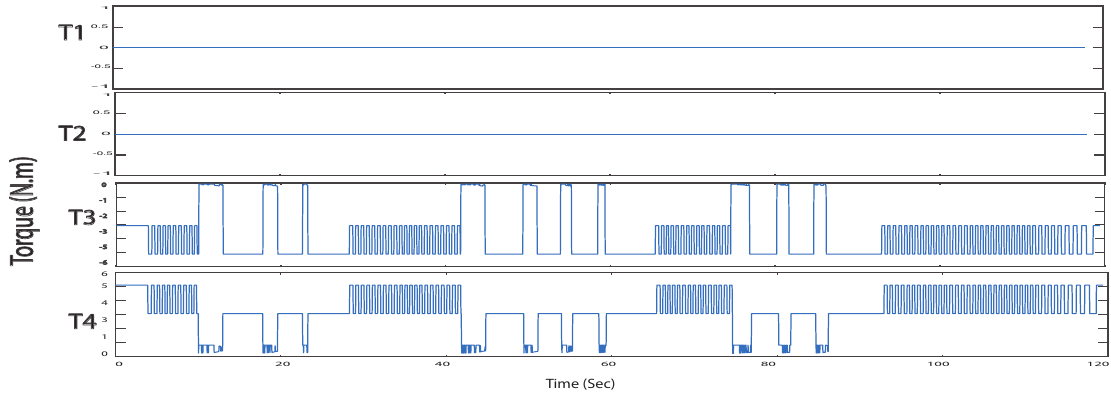
Figure 16. Path of the robot for state 5: Front wheels are faulty (Wheel 1 and 2).